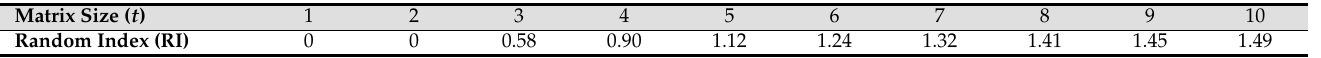
Table 7. Random Index ( RI ) value for different size of comparison matrix ( t ) by Saaty